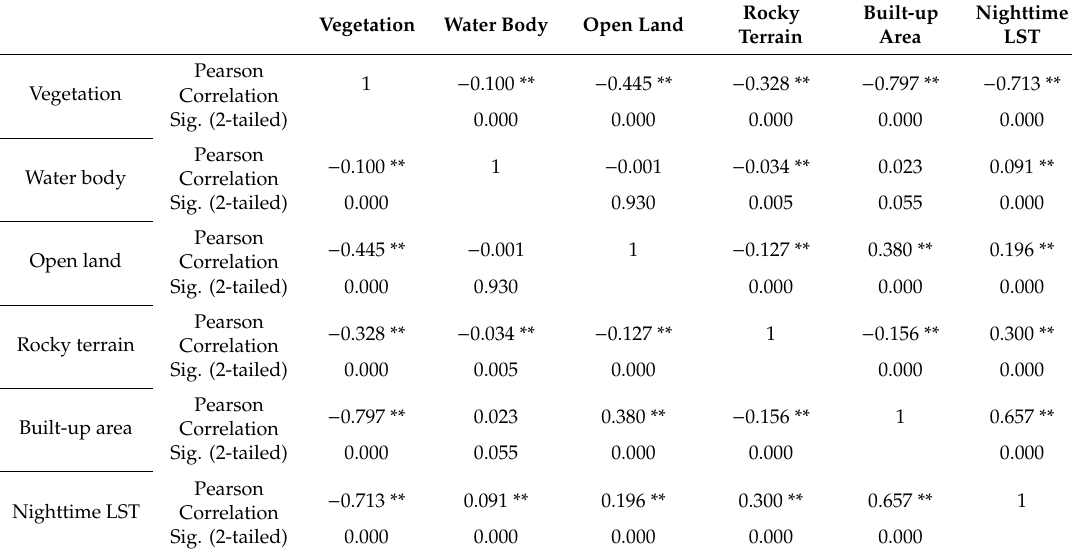
Table 3. Correlation matrix between nighttime land surface temperature (LST) and land use and land cover